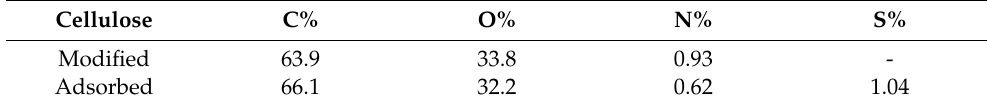
Table 1. The proportional of element in the cellulose.